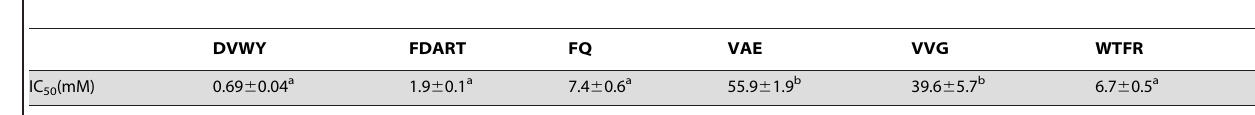
Table 1. In vitro ACE-inhibitory activities (IC 50 ) of FBPs.